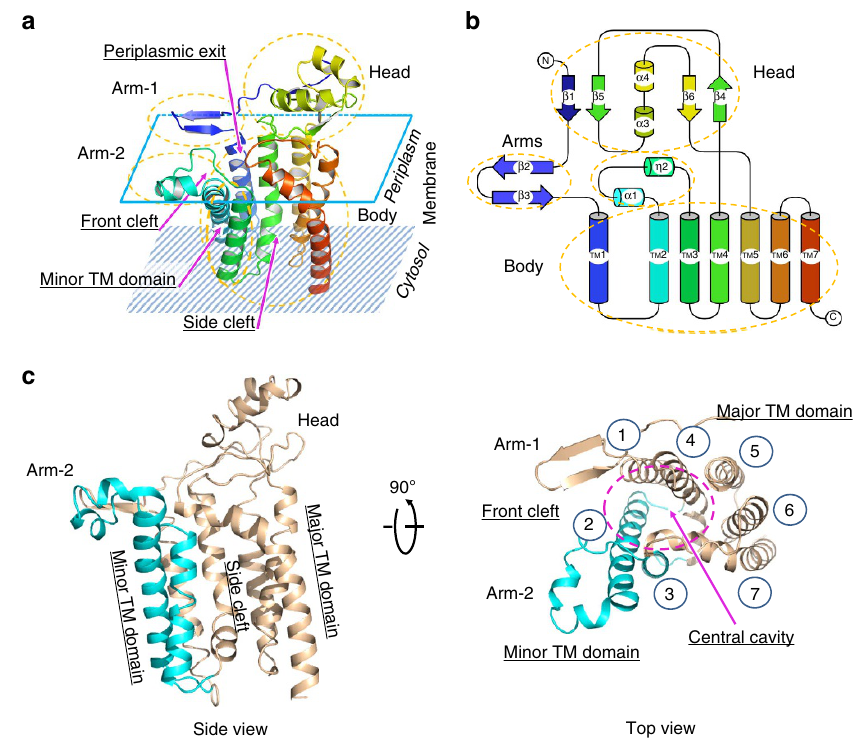
Figure 2 | Overall structure of Ec Lgt. ( a ) Ribbon presentation. The peptide chain of Ec Lgt is coloured in a rainbow scheme, with the N terminus in blue and C terminus in red. Electron densities of the overall structure of Ec Lgt are shown in Supplementary Fig. 7. ( b ) Topology of the peptide folding. The seven TM helices (labelled as TM1–TM7) and periplasmic helices ( a 1, Z 2, a 3 and a 4) are shown as cylinders, and b -strands ( b 1– b 6) with arrows. ( c ) Side and top views. The minor TM domain is shown in cyan, and the remaining parts in wheat colour. In the top view, the head domain is removed for clarity, and TM helices are numbered 1–7.